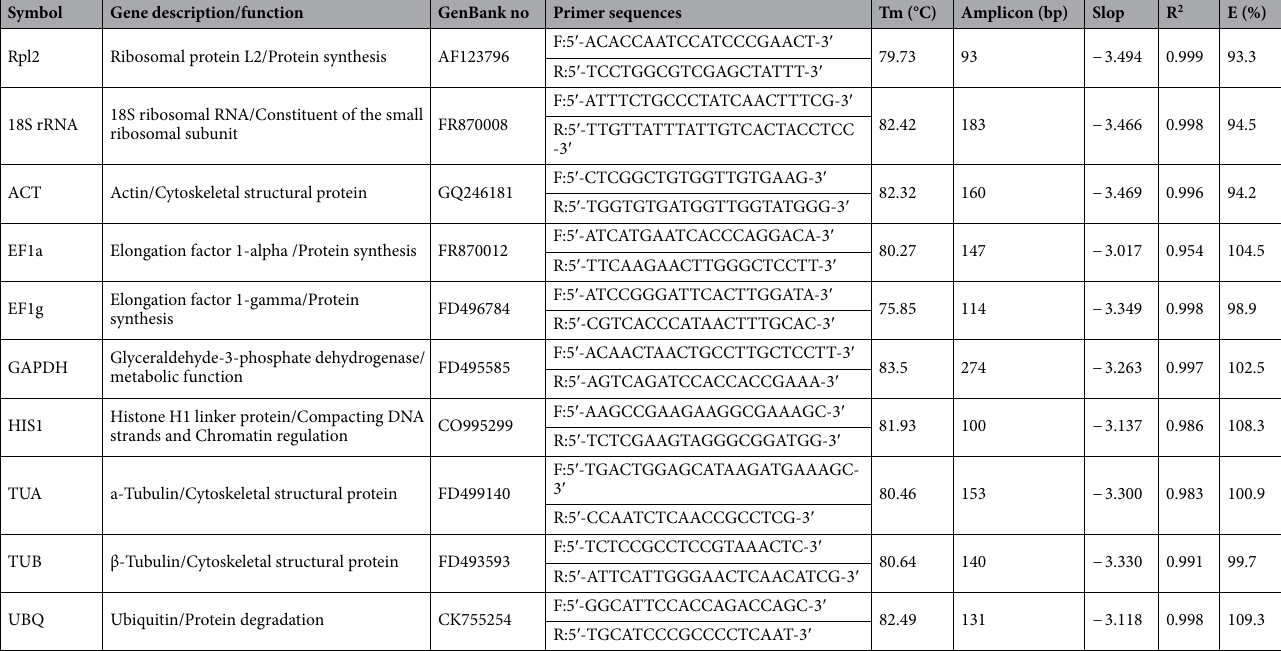
Table 5. Descriptions of Liriodendron hybrids’ candidate reference genes and associated qPCR analyses. F forward primer, R reverse primer, Tm melting temperature, Slop standard curve slope, R 2 regression coefficient, E amplification